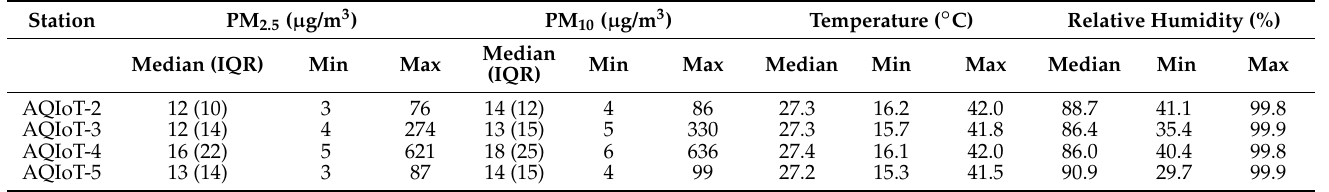
Table 2. Descriptive statistics of meteorological factor data and particulate matter concentration